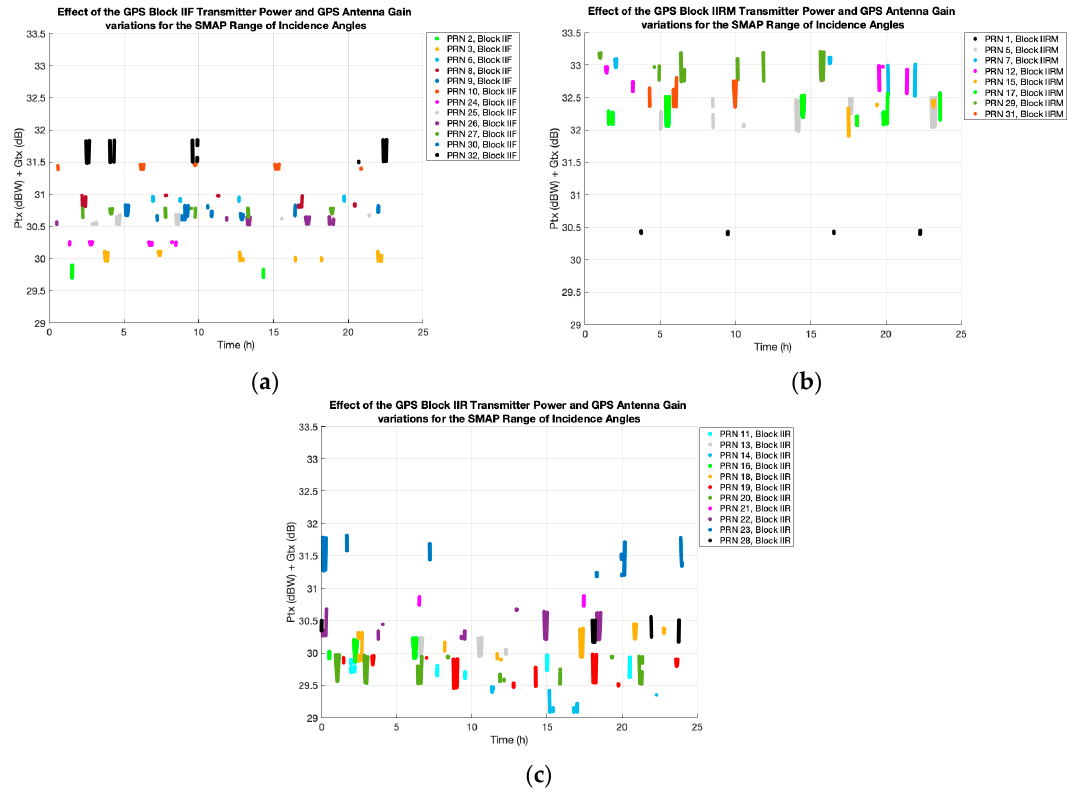
Figure 7. Combined GPS Equivalent Radiated Isotropically Power (EIRP) ( P tx G tx ) for the measured range of incidence angles (37.3° to 42.7°) and for the 32 satellites of the constellation. The main information of this plot is in the total variation range of those transmitted power. Each color corresponds to a different GPS satellite. ( a ) GPS block IIF satellites are represented by circles, ( b ) GPS block IIRM satellites are represented by squares, and ( c ) GPS block IIR are represented by crosses.